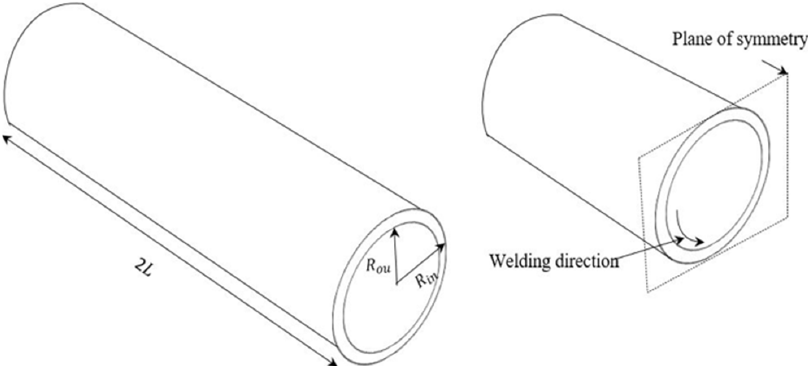
Figure 3. Pipe geometry model.